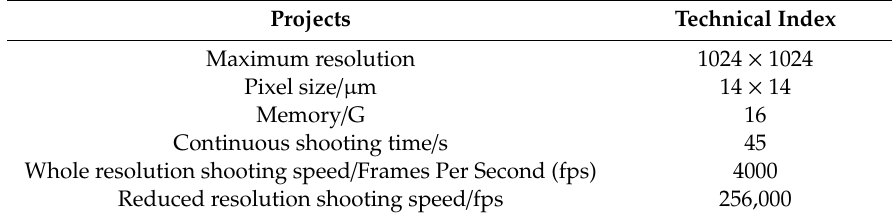
Table 2. Specific parameters of the camera.